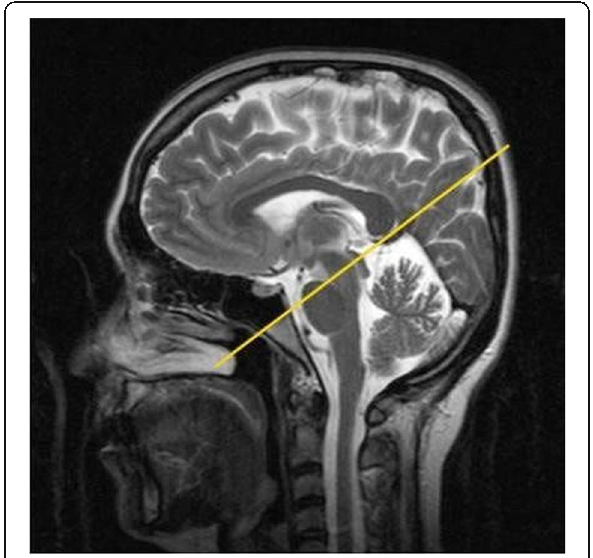
Fig. 4 Semi-axial plane that lies perpendicular to the cerebral